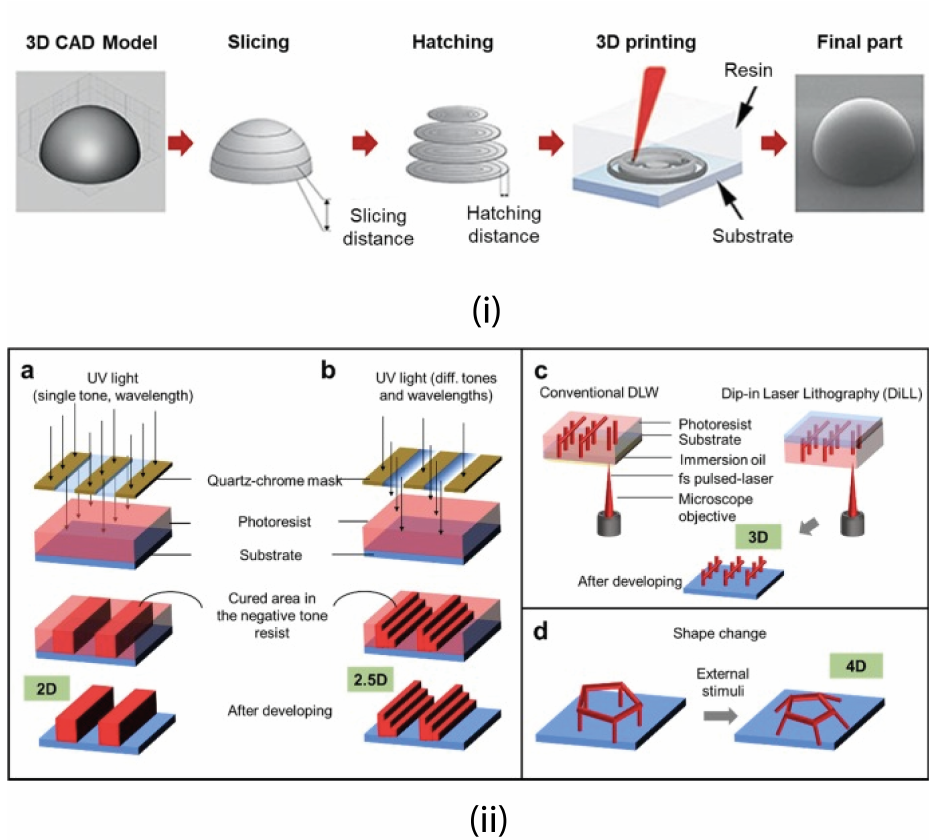
Figure 7. Different printing processes of microbots using light: ( i ) Steps involved in a direct laser writing fabrication process. The design process begins with a 3D CAD model (STL format) integrated into the 2PP system programming software. After converting the file to the 2PP specialized format, it is divided into multiple layers (depending on the desired resolution and structure size), followed by a hatching process to fill in the majority of the structure. Finally, the 3D model is a near-exact of the initial CAD design. ( ii ) ( a ) traditional 2D photolithography, which produces 2D structures with the same heights, ( b ) gray-tone photolithography, which produces non-freestanding 2.5D structures with different heights, ( c ) two-photon polymerization approach with two different possible writing methods (DLW and Dip-in Laser Lithography DiLL) to fabricate 3D tiny structures, and ( d ) 4D lithography, which produces 3D structures made of materials that respond to an external stimulus [155]. Reproduced under the terms of the CC-BY